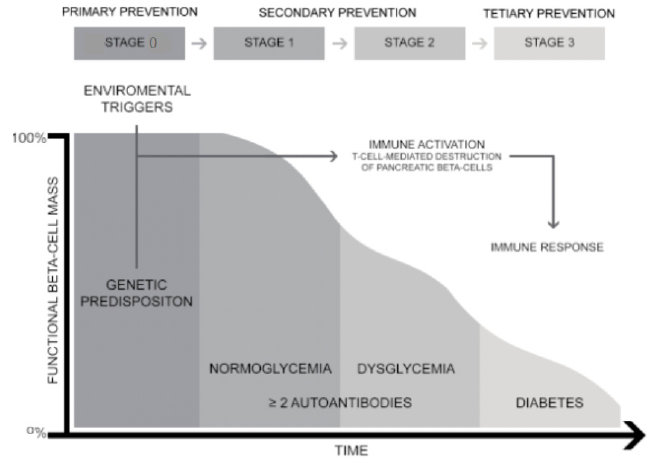
Figure 1. The natural history of Type 1 diabetes (T1D) is based on the referenced model [12] with recently proposed early stages of T1D [13] and prevention opportunities.